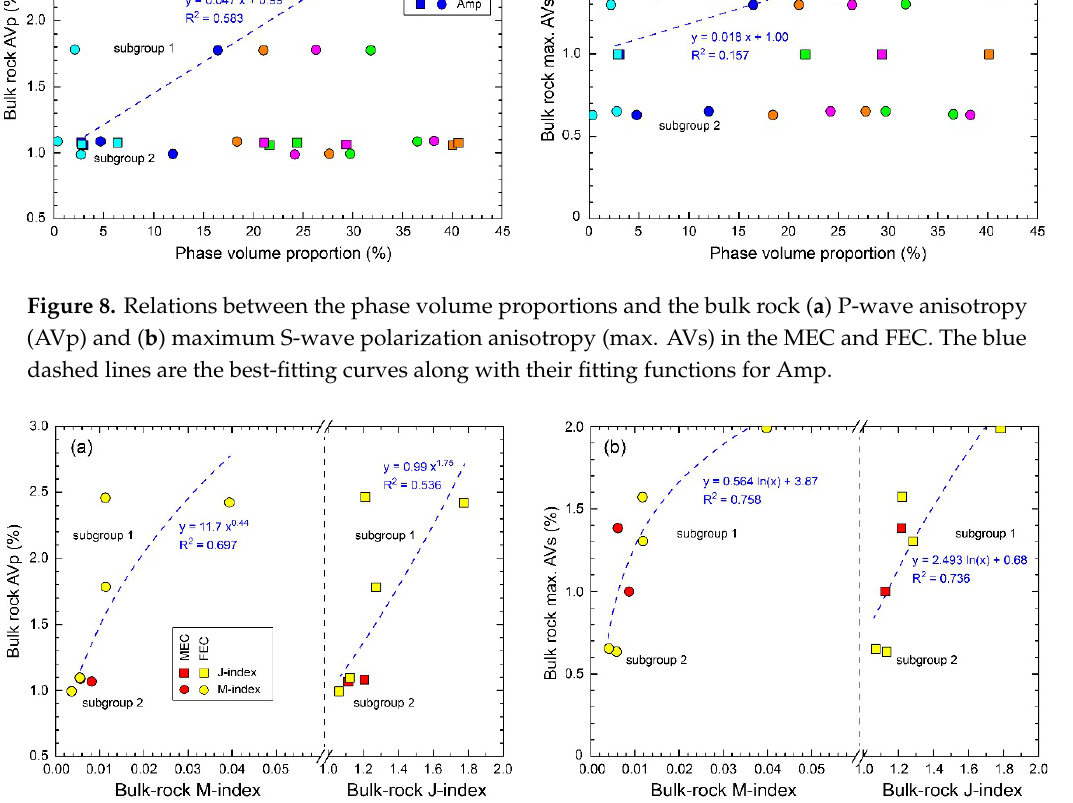
Figure 9. Relations between the bulk rock CPO strength (J- and M-index) and bulk rock ( a ) AVp and ( b ) max. AVs in the MEC and FEC. The bulk rock J- and M-index were averaged J- and M-index of the constituent minerals weighted by their volume proportions. The six and four yellow symbols in the upper and lower parts of each diagram are the FEC subgroups 1 and 2, respectively. The blue dashed lines are the best-fitting curves along with their fitting functions.